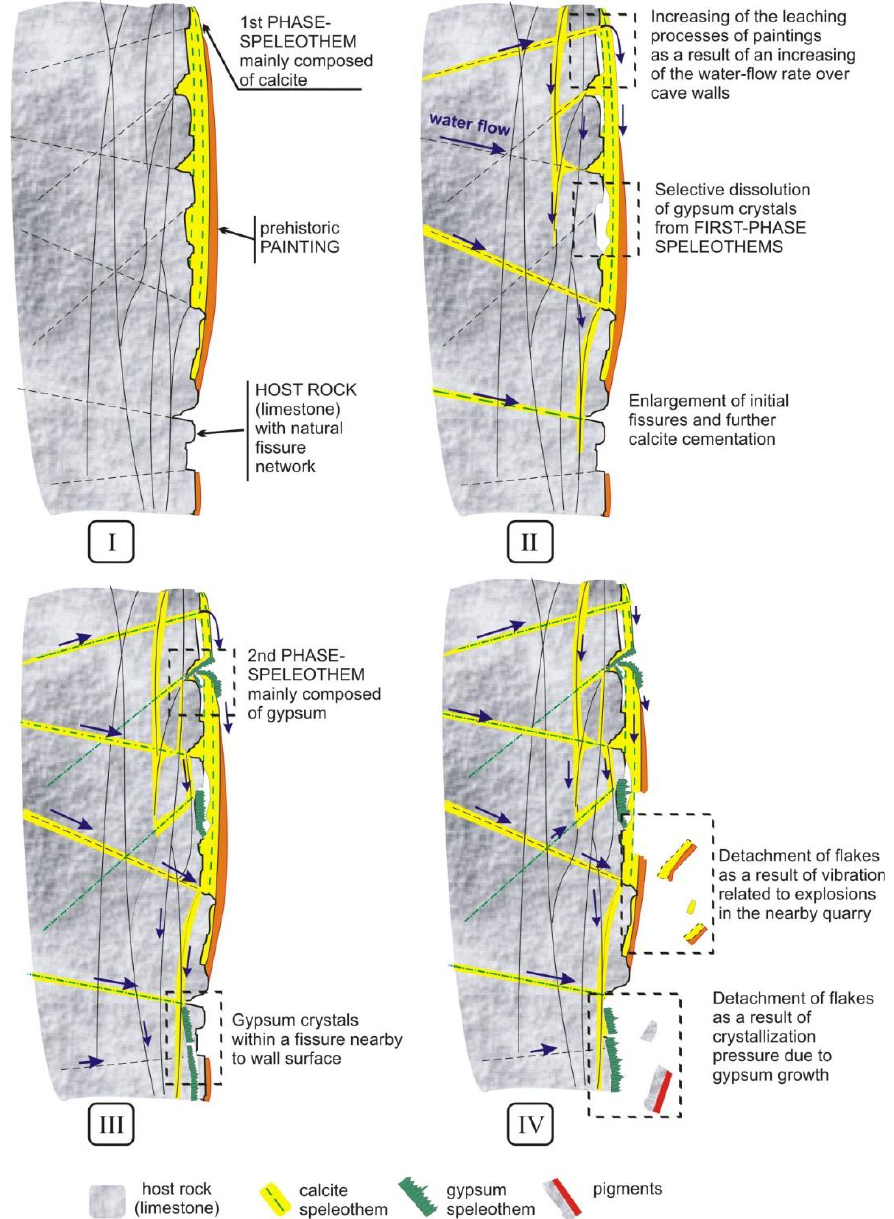
Figure 6. Phases of recent deterioration affecting the cave paintings in Arenaza Cave (see text).